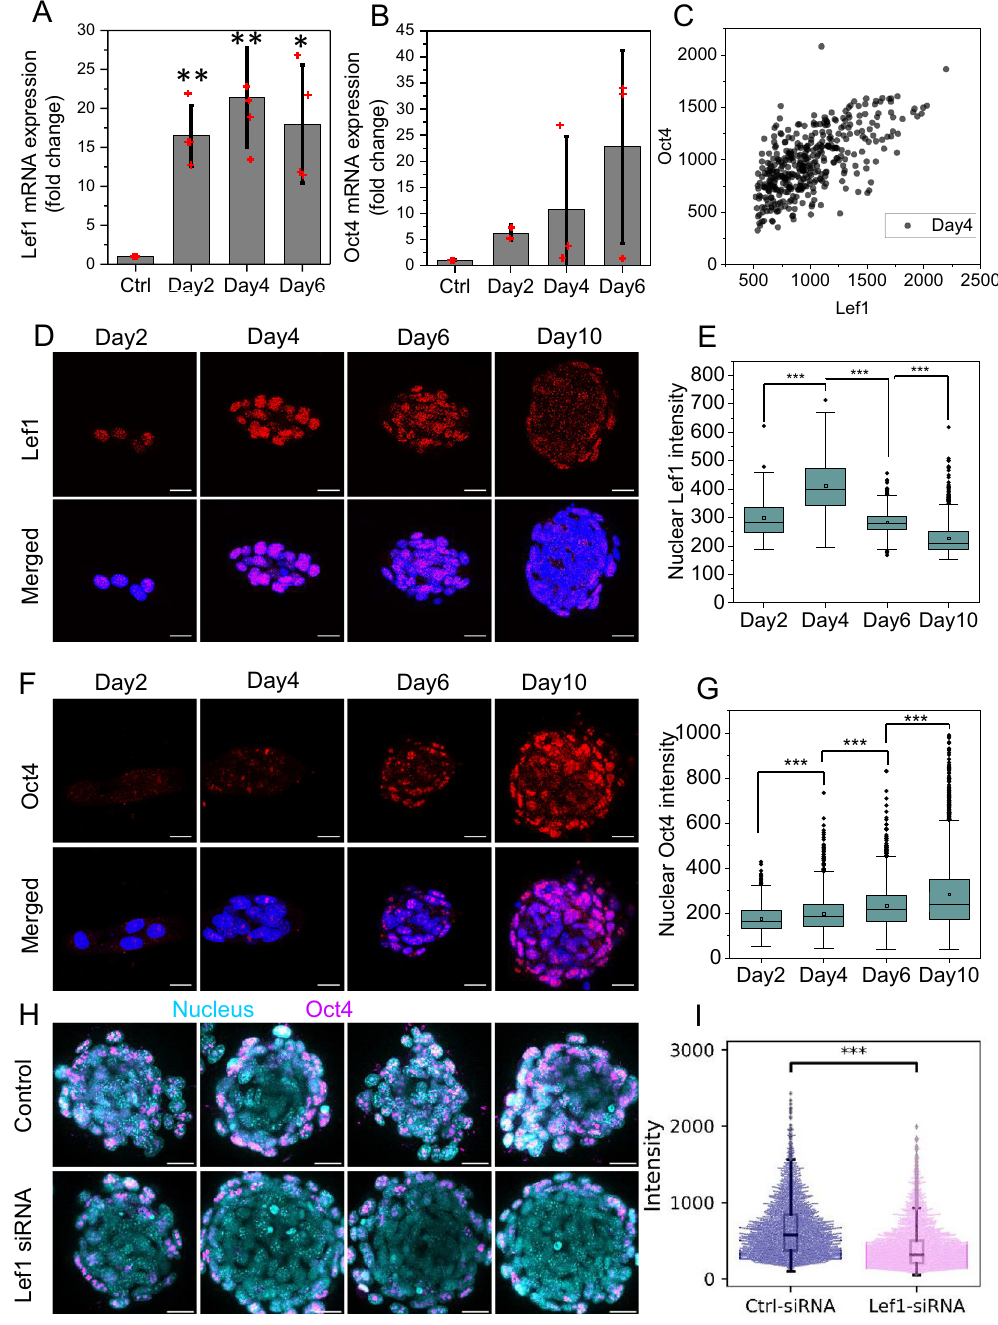
Figure 3. Knockdown of Lef1 and time course studies of Lef1 and Oct4 show the critical role of Lef1 in fibroblast de-differentiation. ( A , B ) Bar plot graphs of Lef1 and Oct4 mRNA expression level over time, error bars represent ± SD. ( C ) The scatter plot of Lef1 and Oct4 nuclear fluorescence intensity. Each dot represents the average intensity for one nucleus. The Pearson correlation coefficient r is 0.64. (D) The fluorescence images of Lef1 (in red) and nucleus (in blue) for cells at day2, 4, 6, and 10. Scale bar is 20 um. ( E ) The box plot shows the quantification of average nuclear Lef1 intensity over time; n = 244, 279, and 673 respectively. ( F ) The fluorescence images of Oct4 (in red) and nucleus (in blue) for cells at day2, 4, 6, and 10. Scale bar is 20 um. ( G ) The box plot shows the quantification of average nuclear Oct4 intensity over time; n = 481, 1486, 1248 and 2472 respectively. ( H ) The fluorescence images of Oct4 (in magenta) and nucleus (in cyan) for control and Lef1 siRNA treated cells. Scale bar is 50 um. ( I ) Quantification of Oct4 nuclear intensity shows distinct distributions for control and Lef1 siRNA samples; *** P < 0.001; n = 2708 and 3171